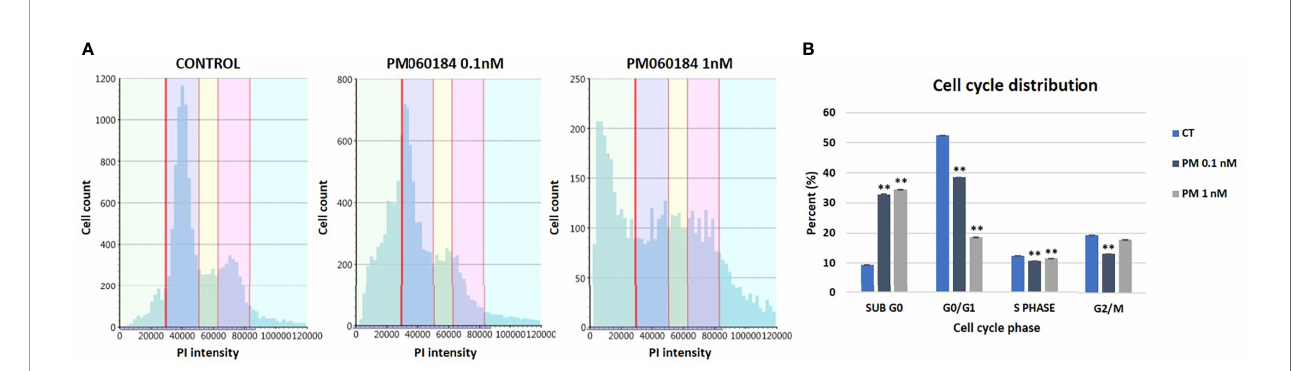
FIGURE 5 | Cell cycle experiments in OV866(2) cells. (A) Cell cycle diagrams obtained by Celigo S plate cytometer of OV866(2) cells treated for 24h with plocabulin at 0.1nM and 1nM, and the untreated control. (B) Bar plots represent the percentage of cells at each phase of the cell cycle. CT: untreated control; PM: PM060184; PI: propidium iodide; **: p value <